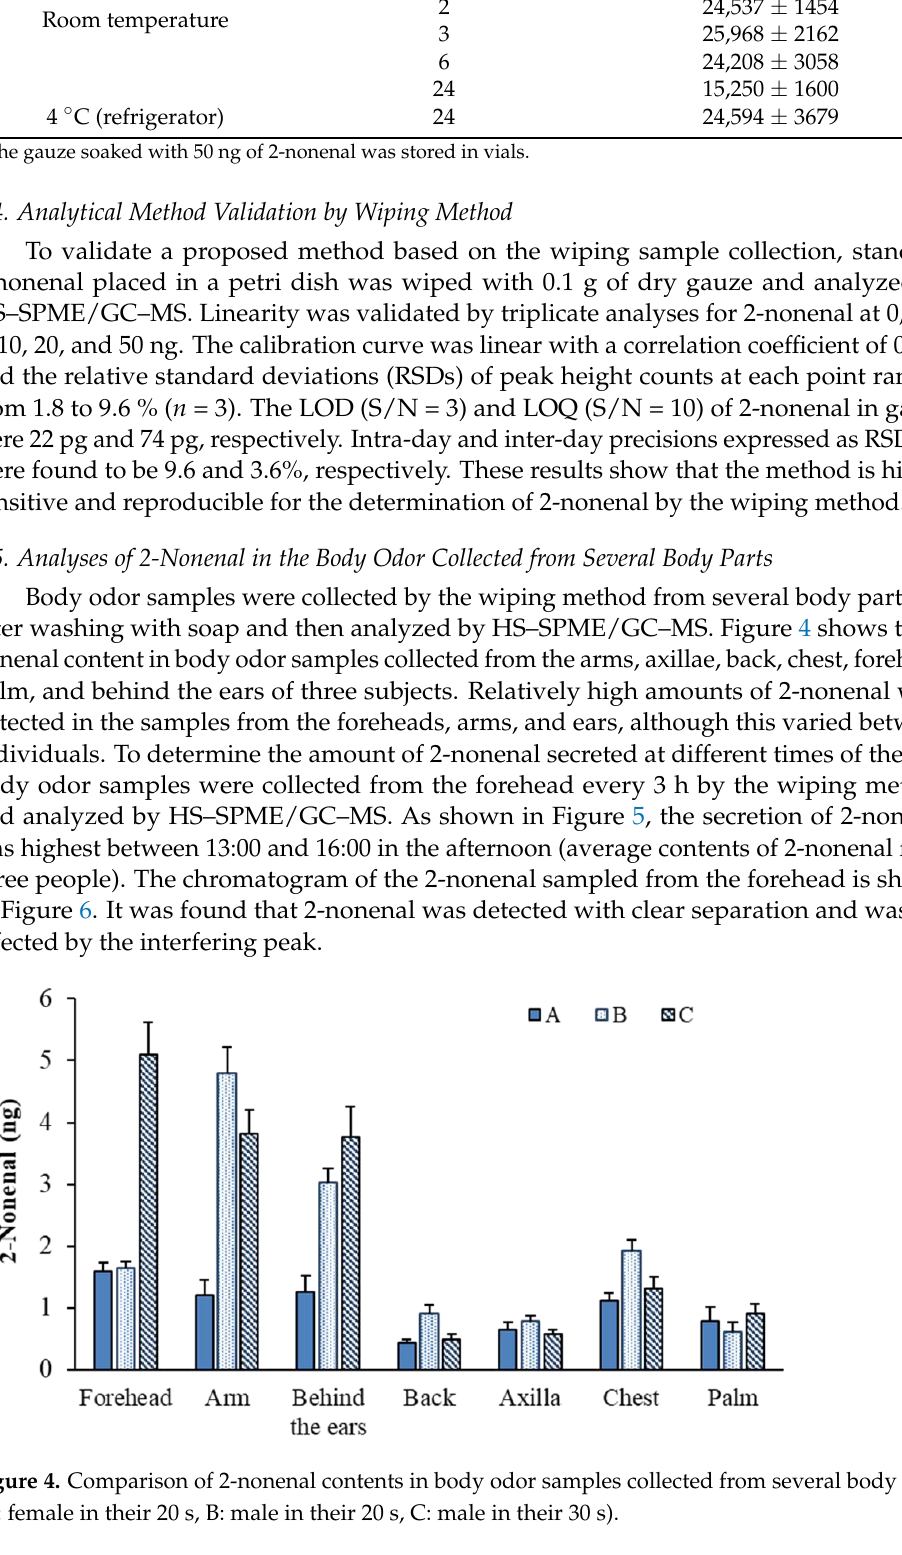
Figure 5. Circadian rhythm of 2-nonenal emission from skin (forehead) (average contents of 2- nonenal from three people).